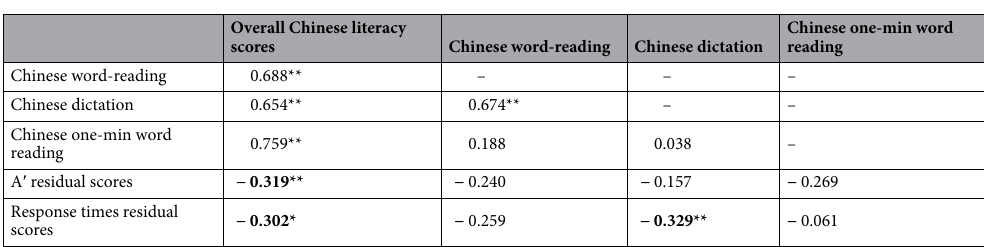
Table 2. Correlations Chinese literacy measures with residuals of A ′ . *p = 0.058; **p < 0.05.